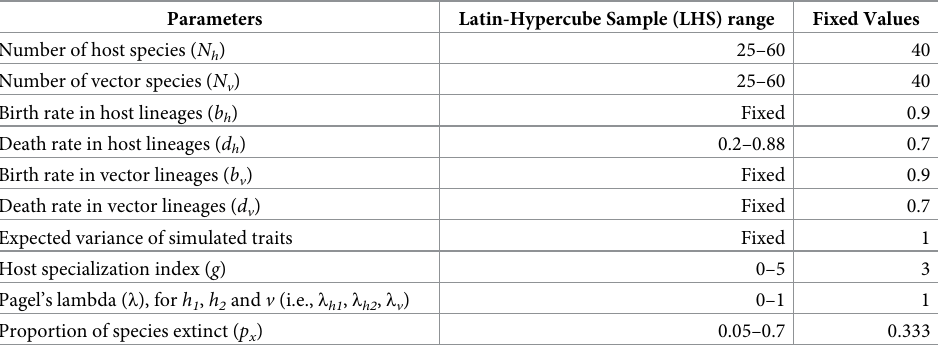
Table 1. Community phylogenetic model and simulation